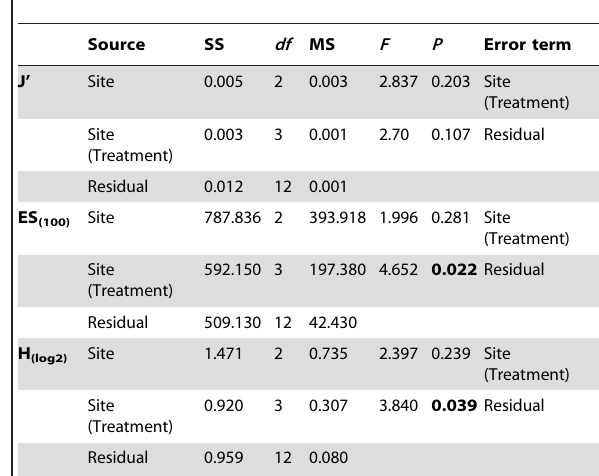
Table 3. Nested ANOVA analysis of differences in diversity indices (0–1 cm sediment depth) between sampling sites (Site) and control and sponge samples